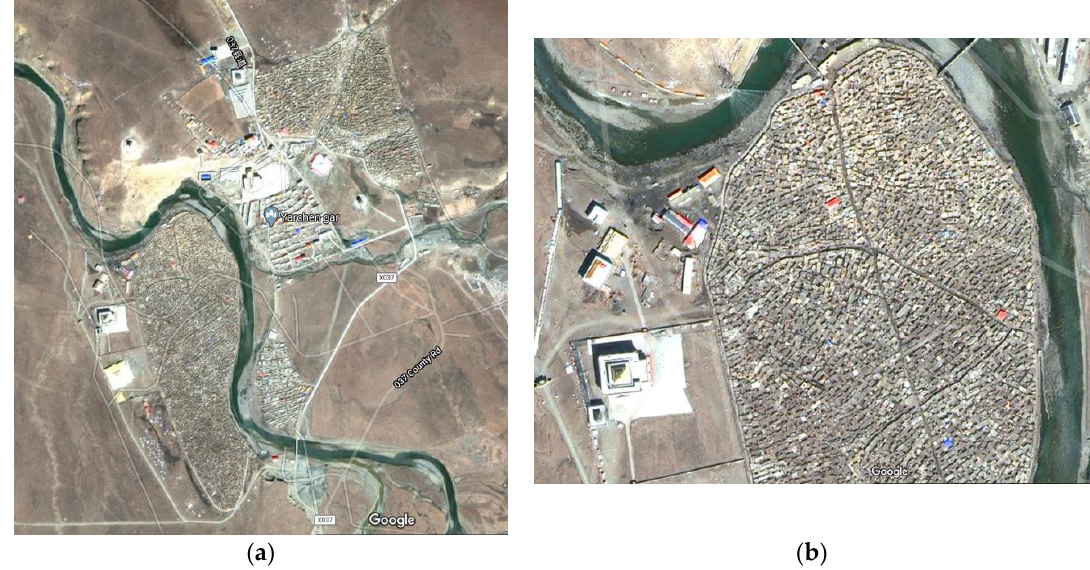
Figure 1. ( a ) The satellite photo of Yachen Gar clearly shows the spatial set-up. The main buildings, as well as the living quarters of the monks, are situated on the northern side of the river. ( b ) (detail) The nun’s living quarters are on the south side. According to recent reports, the entire eastern part of the nun’ s living quarters on the embankment of the river was demolished. Source: Google Maps.